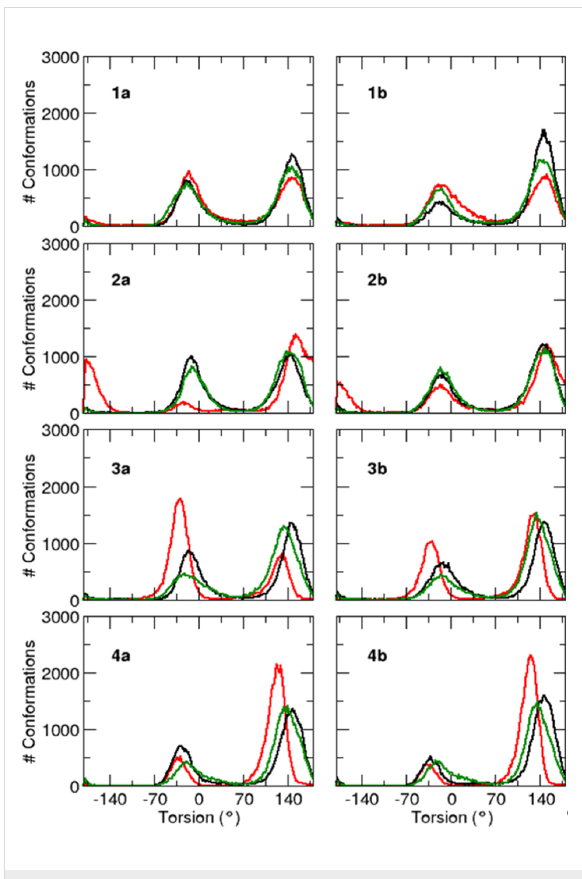
Figure 3: Probability distribution of the peptide dihedral angles ψ for the three central residues Val 2 (black), X 3 (red) and Val 4 (green).